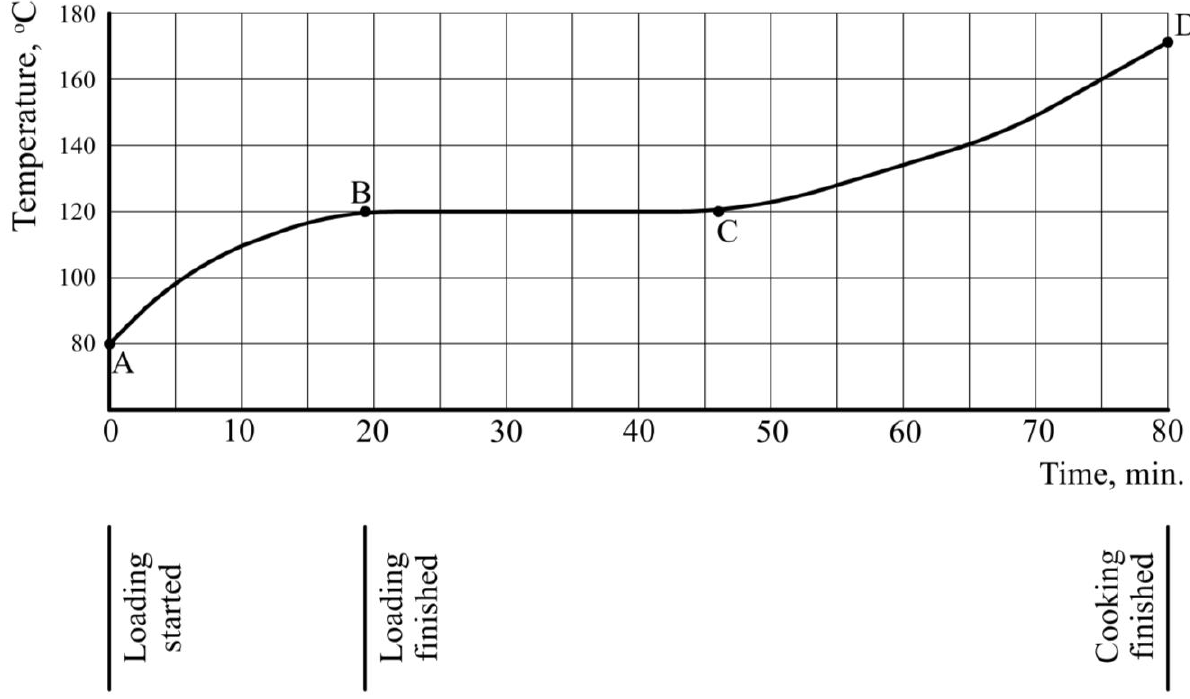
Figure 2. Temperature curve for the thermal treatment of gypsum